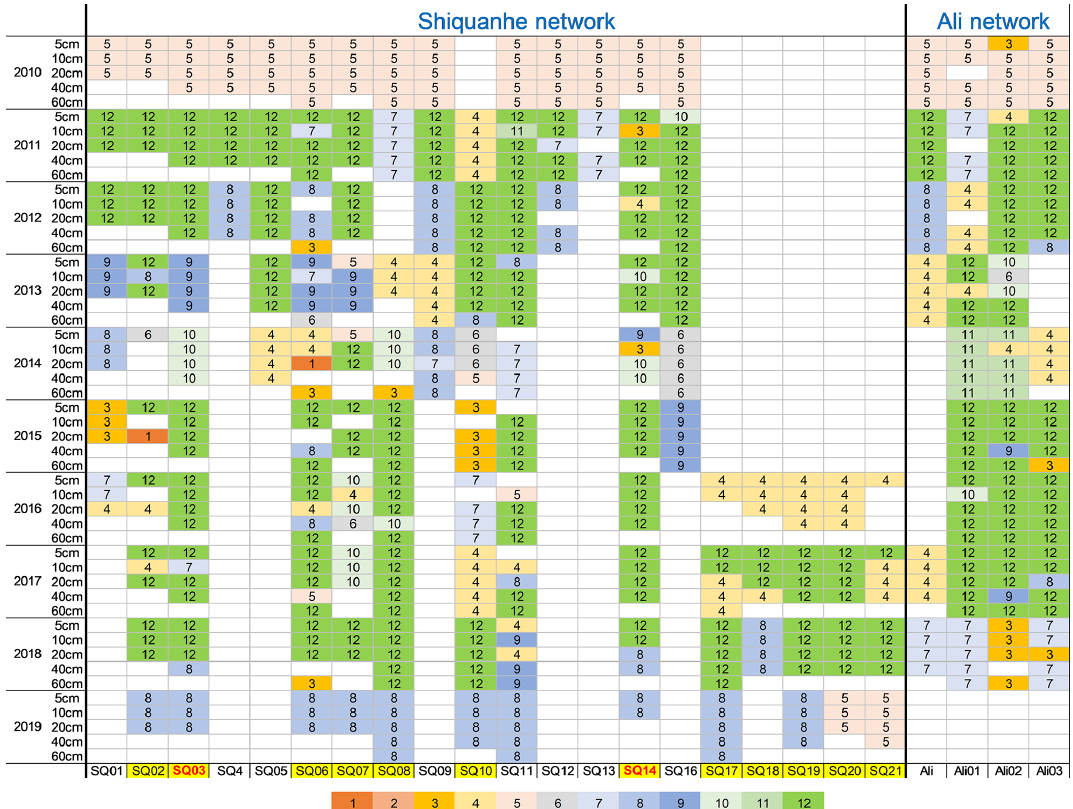
Table A2. Same as Table A1 but for the Ngari network with temporal persistence from August 2010 to August 2019. Site names that are highlighted and have a red font represent the sites used to produce the long-term (August 2010–August 2019) upscaled SMST dataset, and site names only highlighted represent the sites used for generating ground truth for a selected year (August 2017–August 2018) in the Shiquanhe